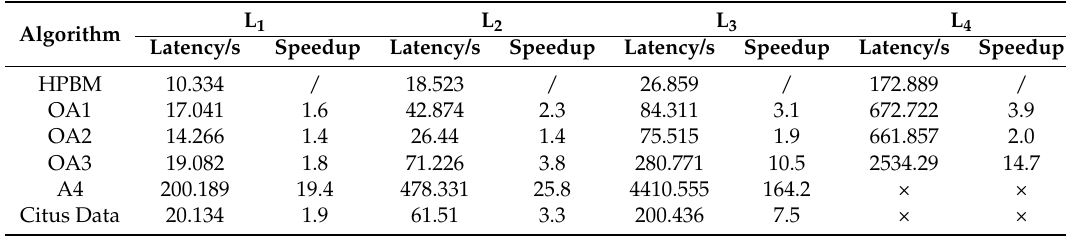
Table 8. Cluster